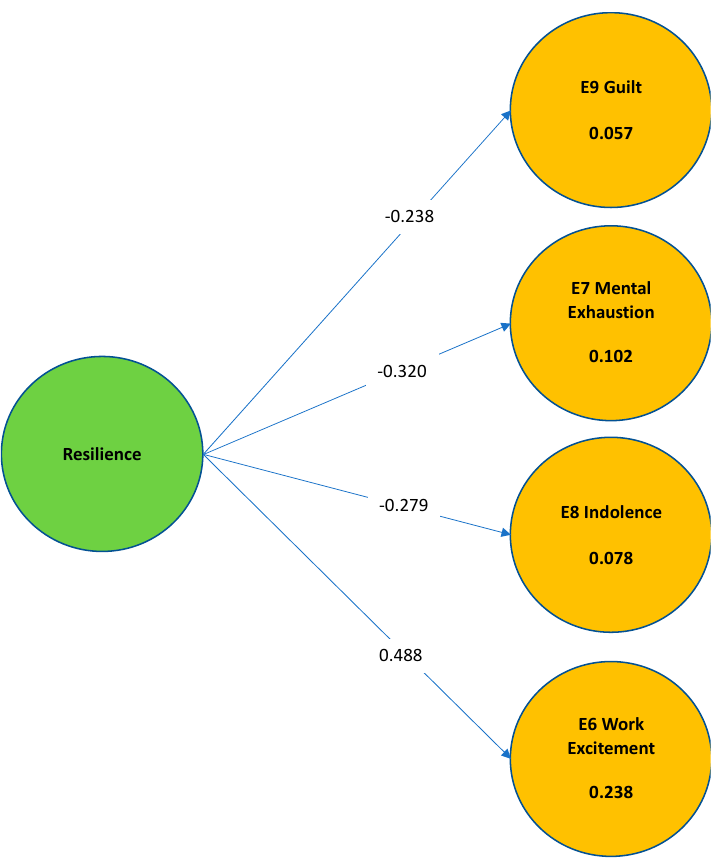
Figure 3. Ex-Post Model of structural equations of the hypothesis test. Source: Own elaboration.